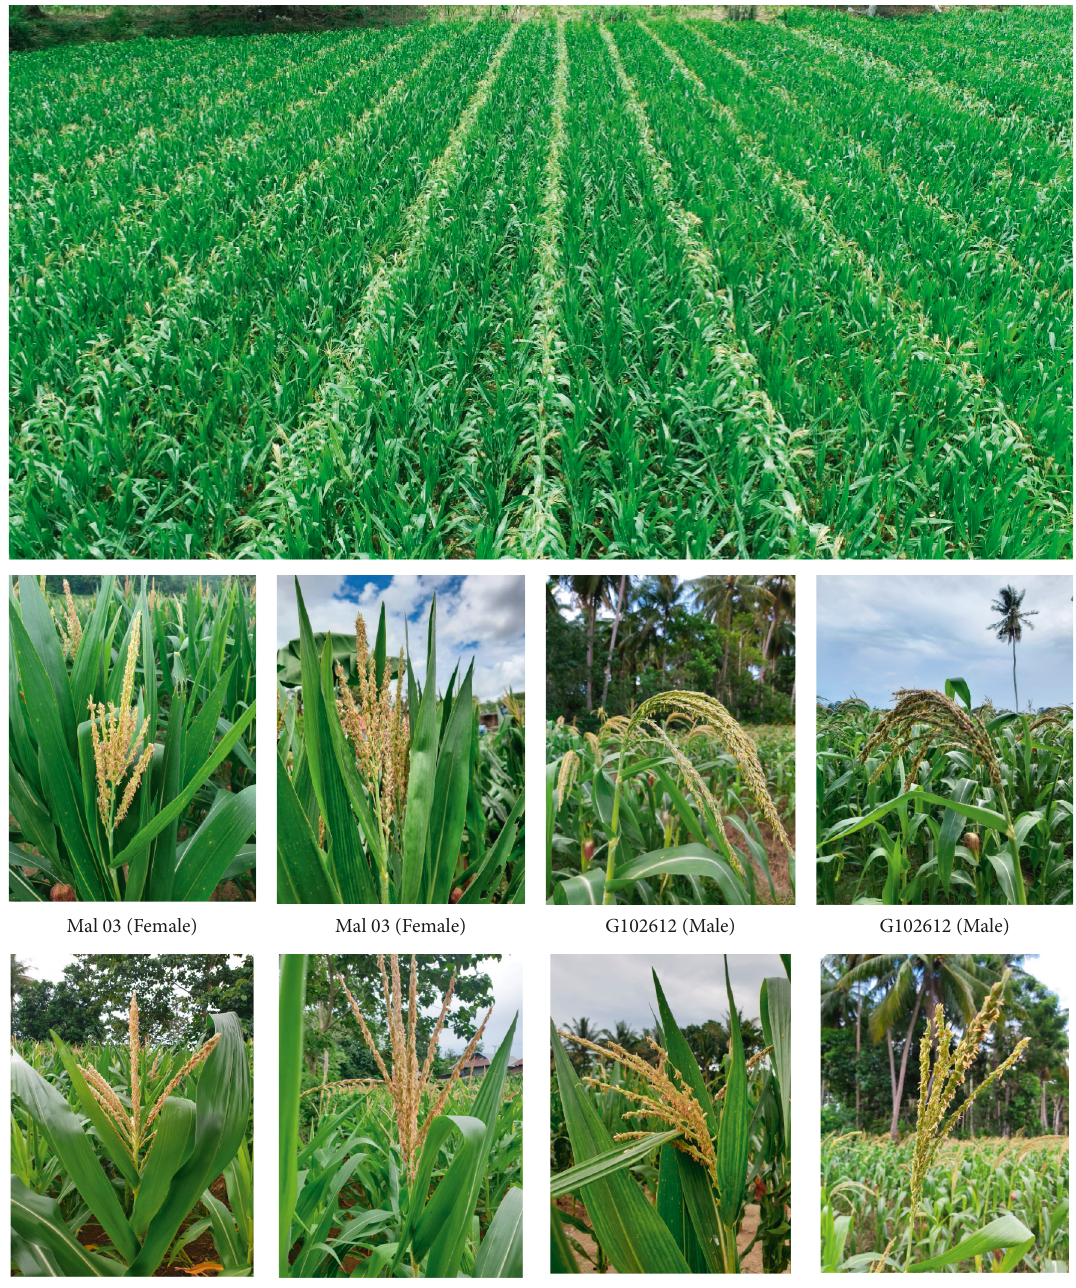
Figure 1: Tassel/flower removal and types of parental lines existed in the